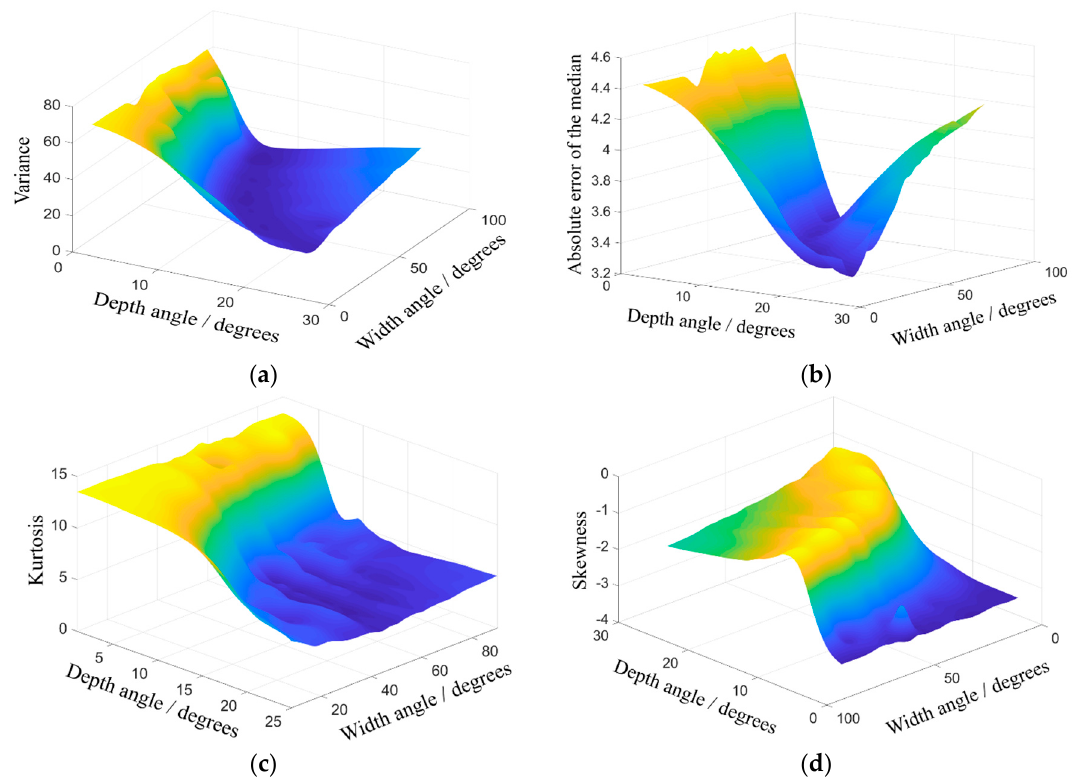
Figure 11. The Figure shows the variations of picked time domain features: ( a ) variations of variance; ( b ) variations of median absolute deviation; ( c ) variations of kurtosis; ( d ) variations of skewness. The optimizing index is expressed as: